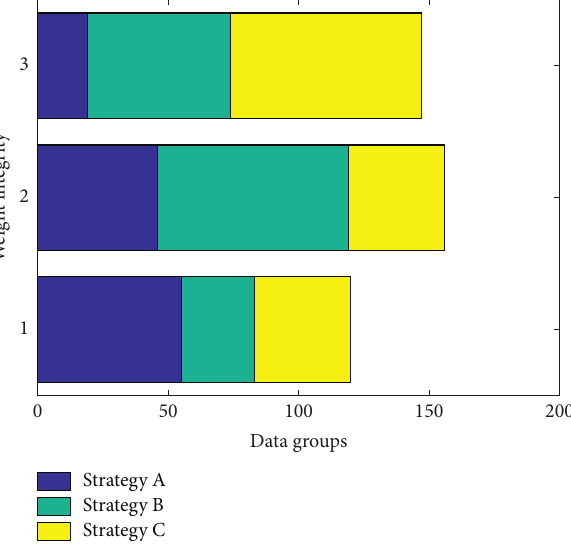
Figure 4: Histogram of model node